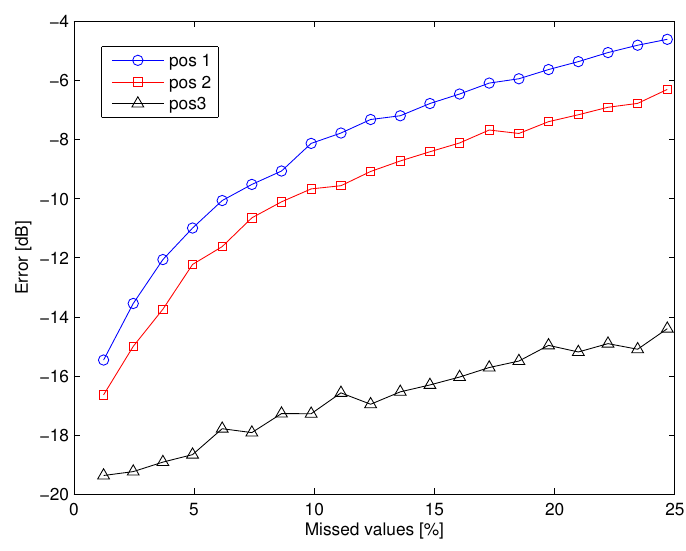
Figure 14. Estimation error (dB) of the channel matrix in the three positions shown in Figures 7d (pos1), 10d (pos2) and 11d (pos3) versus the percentage of the missed elements of the channel matrix.